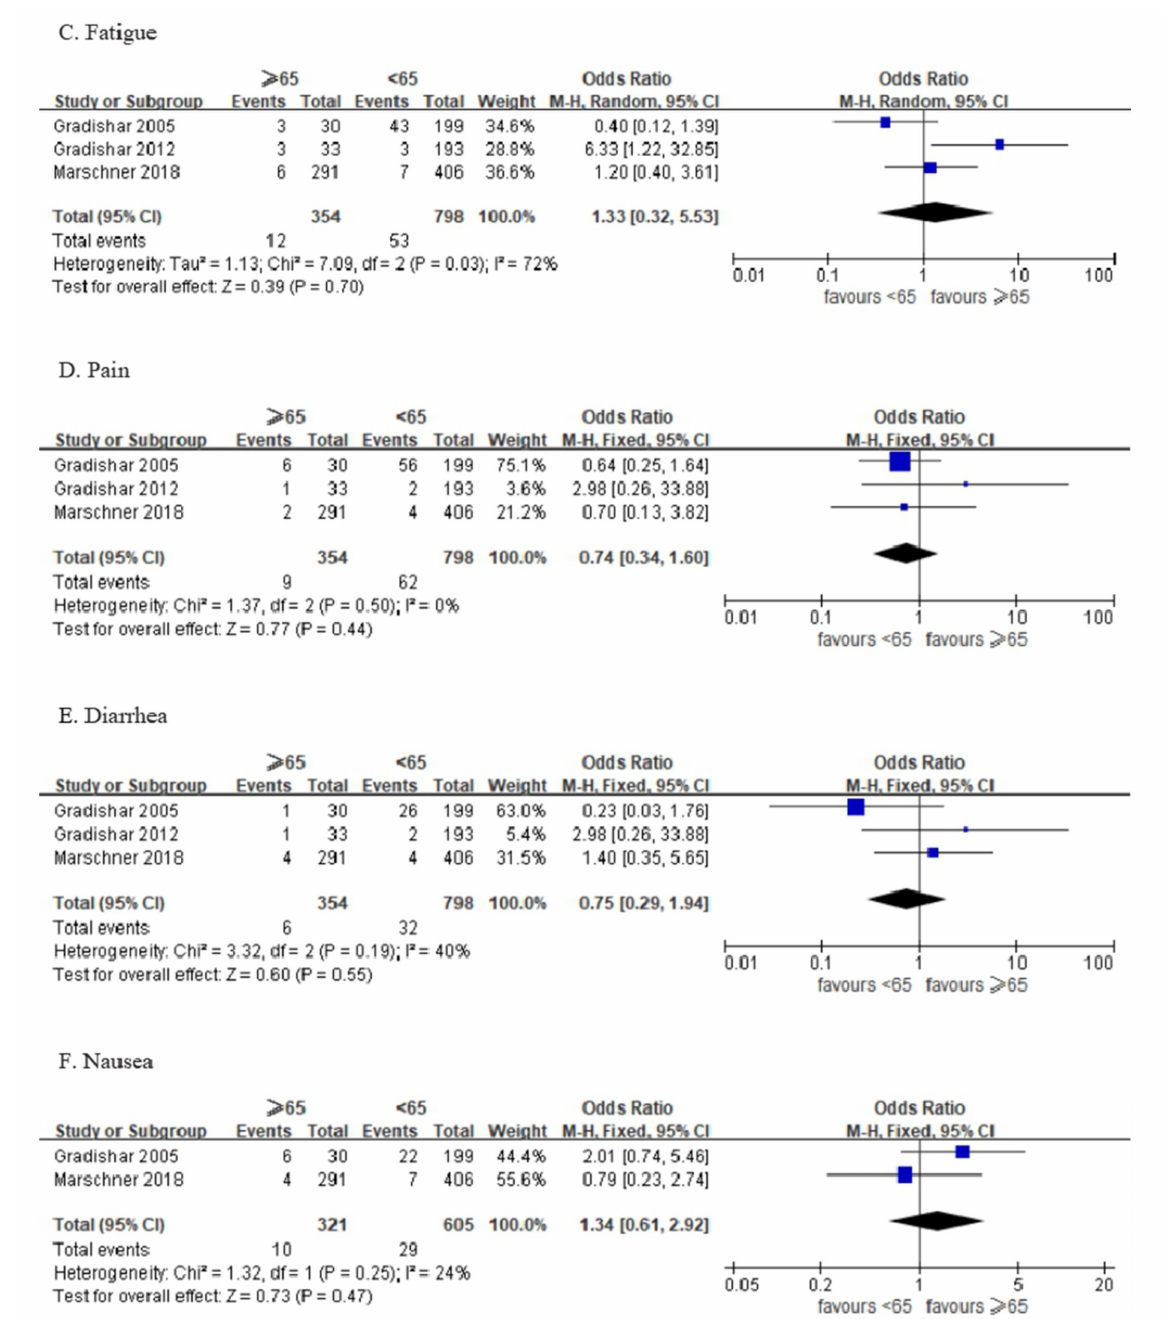
Figure 3. Forest plot of the included studies assessing ( A ) neutropenia, ( B ) sensory neuropathy, ( C ) fatigue, ( D ) pain, ( E ) diarrhea, and ( F ) nausea between patients ≥ 65 years and patients under 65